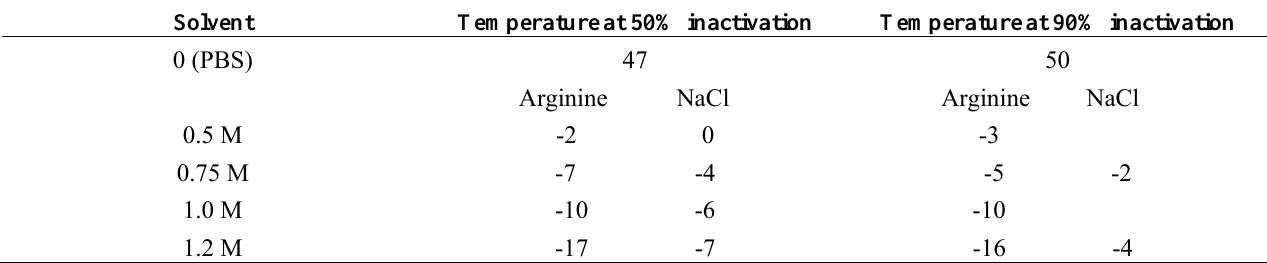
Table 1. Temperature of 50 and 90% virus inactivation with either aqueous arginine or NaCl solution buffered with 10 mM phosphate, pH 7.0. The concentration of both arginine and NaCl are indicated in the